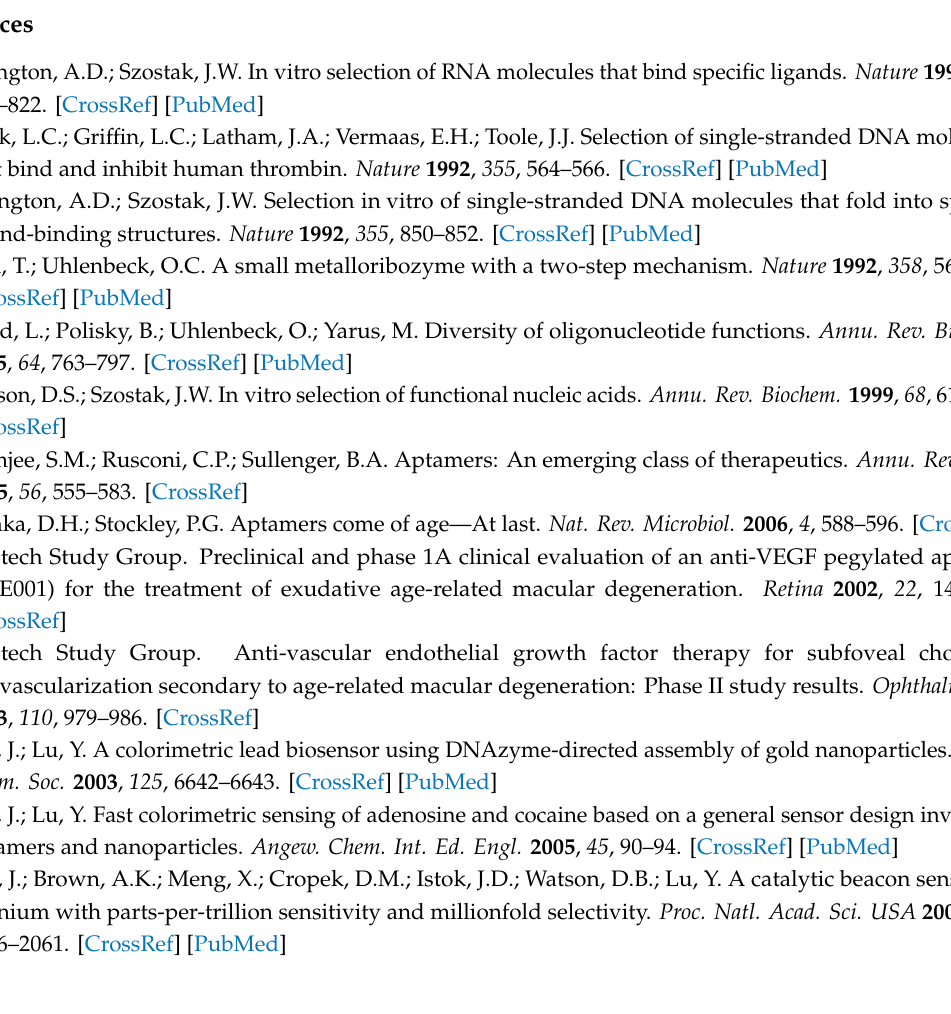
Figure S1. Strand routing diagram of our X-shaped 3D plasmonic metamolecule. Figure S2. Gel purification and characterization of AuNR conjugated metamolecules. Table S1. Parameters for the Hill equation fit of CD response curve against thrombin. Figure S3. Thrombin detection with metamolecule that locks with left-handed chirality. Figure S4. CD spectra of metamolecules in the presence of thrombin or BSA. Author Contributions: W.B. and T.L. designed the experiment. W.B. and T.F. performed the experiment. W.B. and T.L. wrote the